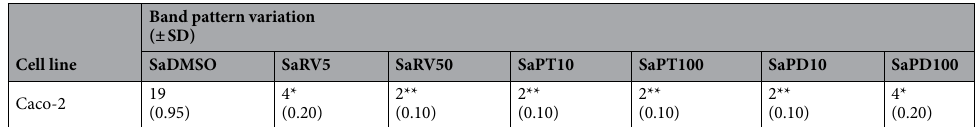
Table 2. Values of band pattern variation obtained by MeSAP analysis (± Standard Deviation of two independent experiments) and densitometer scanning of fingerprinting of mono-digested DNA (MDD) in comparison with double-digested DNA (DDD) expressing the demethylation treated Caco-2 DNA at genome level. (*) 0.01 < p < 0.005; (**) p < < 0.001 calculated with the χ 2 test in comparison with respective DMSO- treated cells